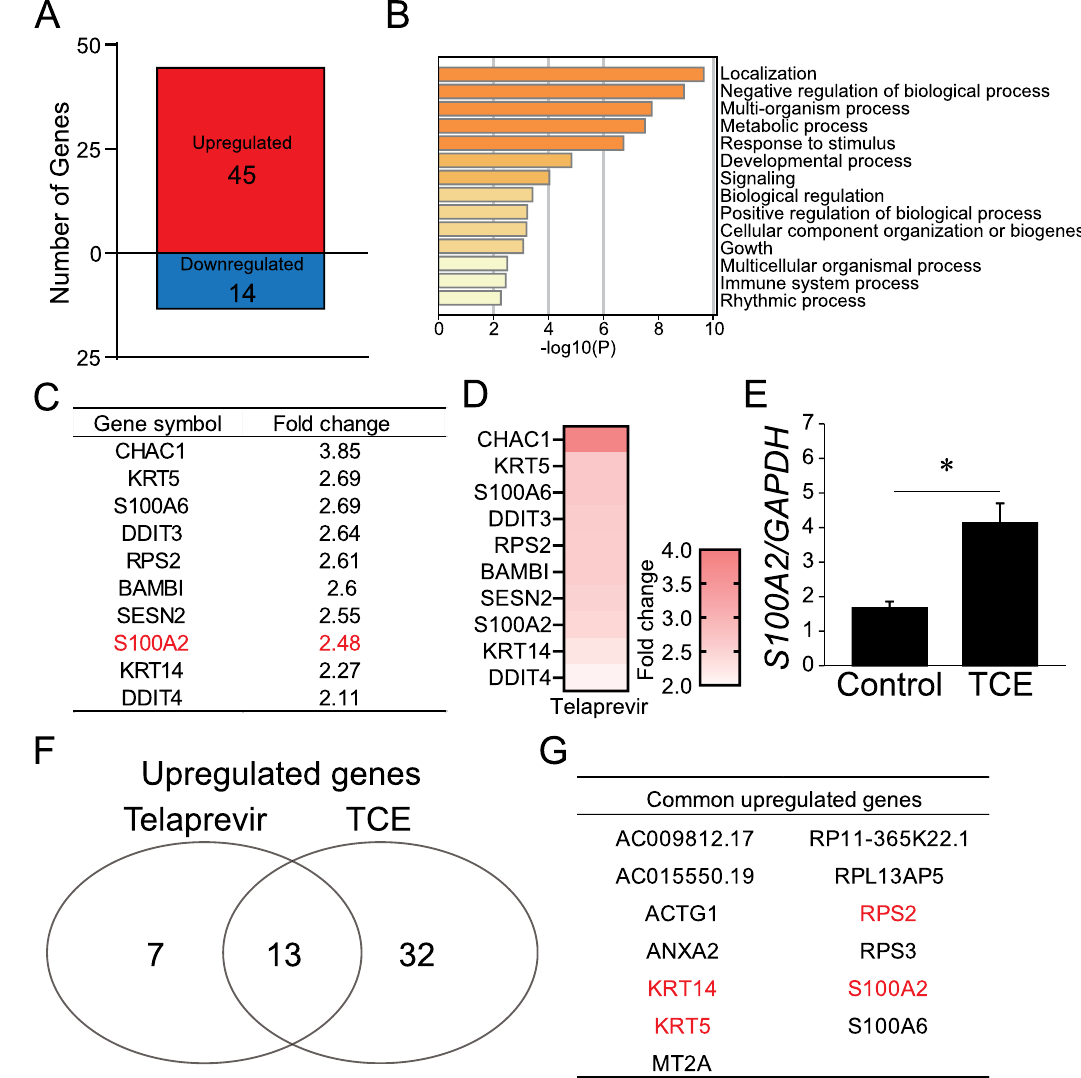
Figure 2. The expression of S100A2 in TCE-treated keratinocytes. ( A ) Microarray analysis of the dysregulated genes in keratinocytes after TCE treatment. ( B ) GO enrichment analysis of upregulated genes in TCE-treated keratinocytes. ( C , D ) The list ( C ) and heat map ( D ) of top 10 upregulated genes in keratinocytes by TCE. ( E ) The number of common upregulated genes in telaprevir- and TCE-treated keratinocytes. ( F ) The list of common upregulated genes in telaprevir- and TCE-treated keratinocytes. Four common upregulated genes within the top 10 lists in both telaprevir and TCE groups are highlighted in red. Results are expressed as the mean ± SD. p-values were obtained by the Student’s t -test: *p <